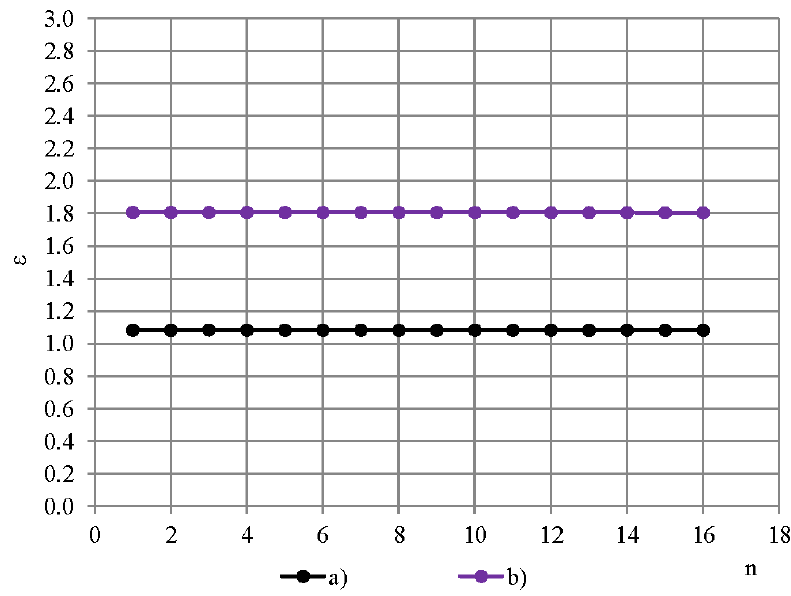
Figure 2. Measured permittivity spectra of a PTFE film, 0.20 mm: (a) OSA sensor and (b) BDS-50.